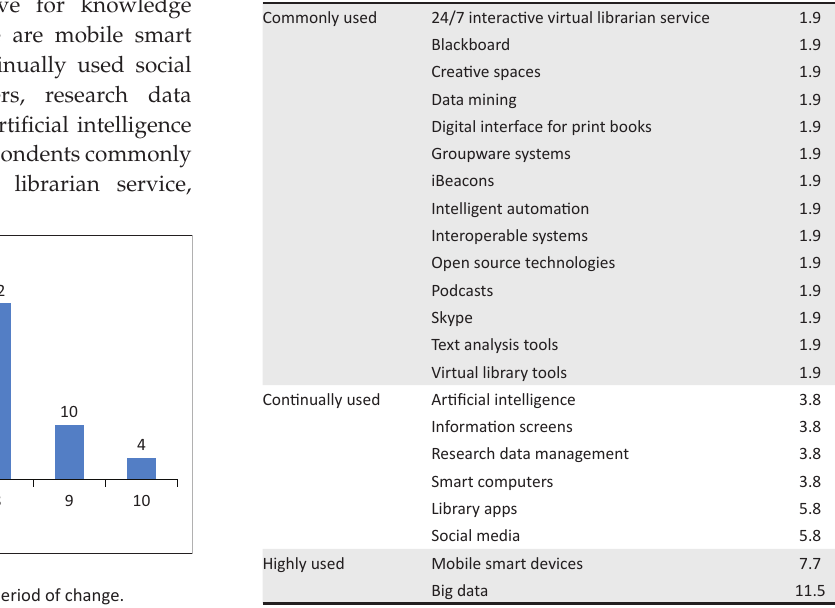
Table 2 ranks technology in three categories: highly used (> 7), continually used (> 3) and commonly used (> 1).